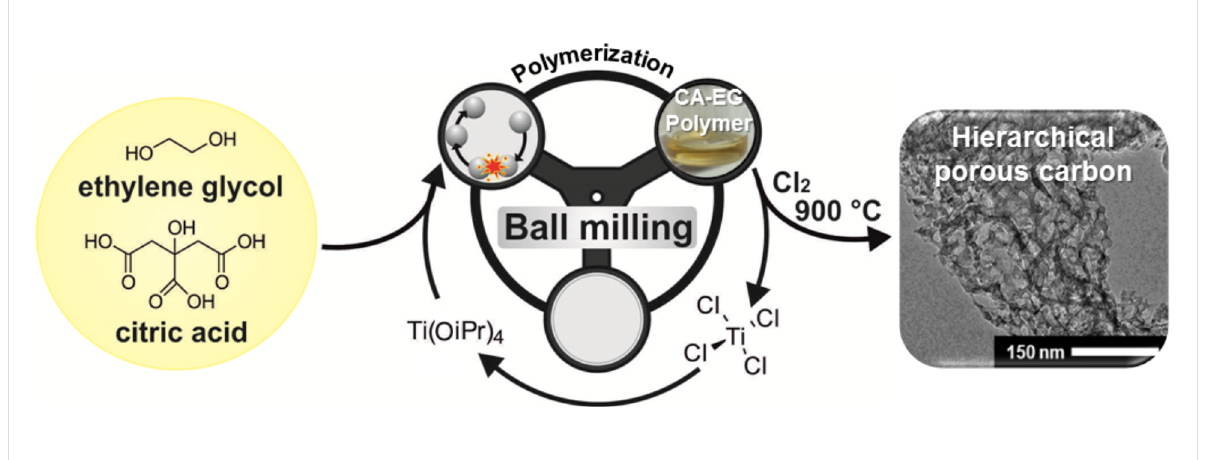
Figure 1: Synthesis of hierarchical porous carbons by mechanochemical polymerization of ethylene glycol (EG) with citric acid (CA) and Ti(IV) isopropoxide as a porogen, resulting in CA-EG polymers. After carbochlorination at 900 °C hierarchical carbons are obtained. The byproduct TiCl 4 can be recycled to be used as Ti(IV) isopropoxide, and acts as porogen in further